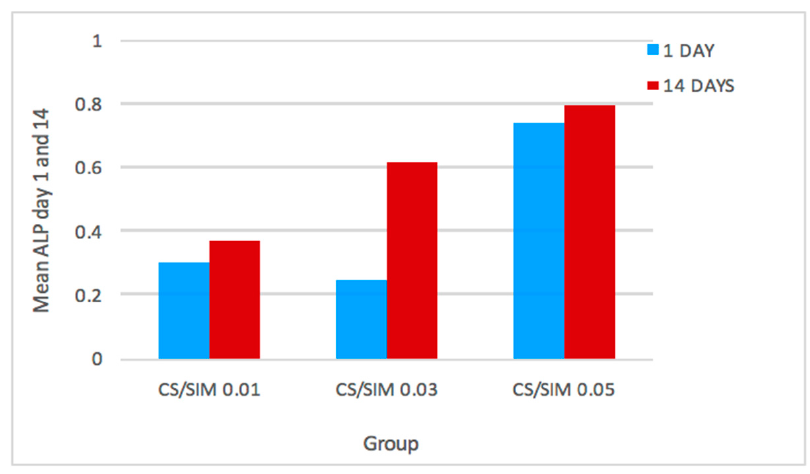
Figure 3. AlamarBlue values indicating cell viability on day 1 and 14. ° a significant difference ( p < 0.05). AB, AlamarBlue; CS, chitosan; SIM, simvastatin.